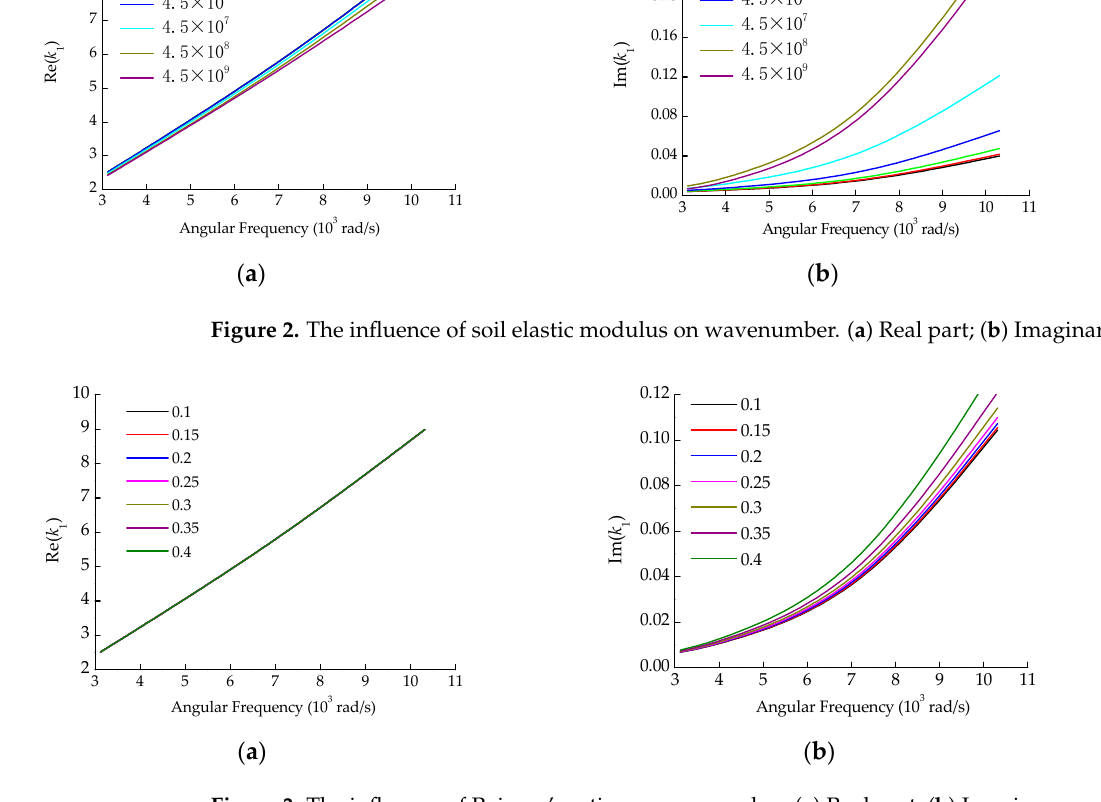
Figure 3. The influence of Poisson’s ratio on wavenumber. ( a ) Real part; ( b ) Imaginary part. Table 1. Properties of the theoretical model for the cast iron pipeline. Properties Fluid Pipe Surrounding